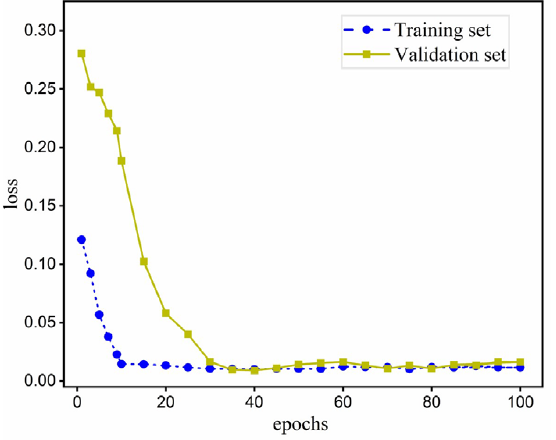
Figure 7. Loss curve.